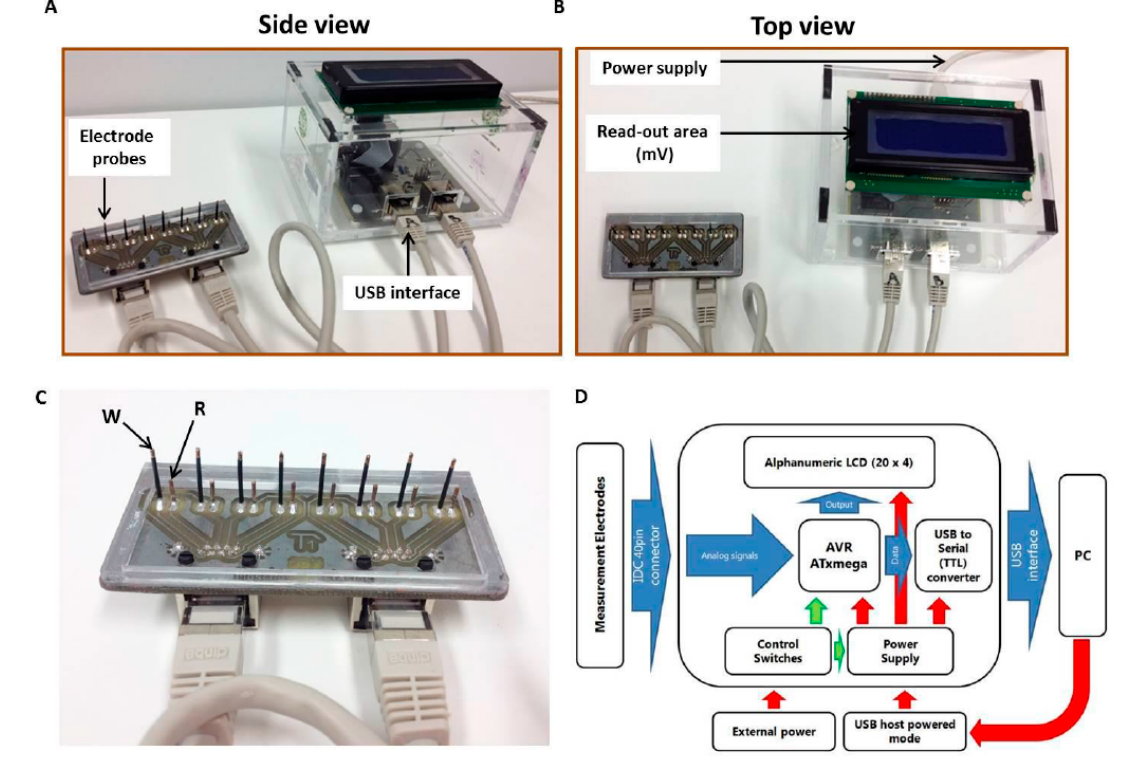
Figure 1. Components of the Metabolite Biosensor Device used to measure the levels of cell membrane potential and the conductivity of cell cultures. ( A ) Side view and ( B ) Top view showing the key features of the Metabolite Biosensor Device. The portable potentiometer (with the read-out area) is connected to the electrode probe through a customized interface. Using this configuration, a maximum number of eight tests can be run simultaneously, corresponding to a row of eight microwells. ( C ) Rear view of the customized electrode probe bearing eight pairs of electrodes for simultaneous signal monitoring (W = working electrode, R = reference electrode). ( D ) System block diagram of the bioelectronics assay system.